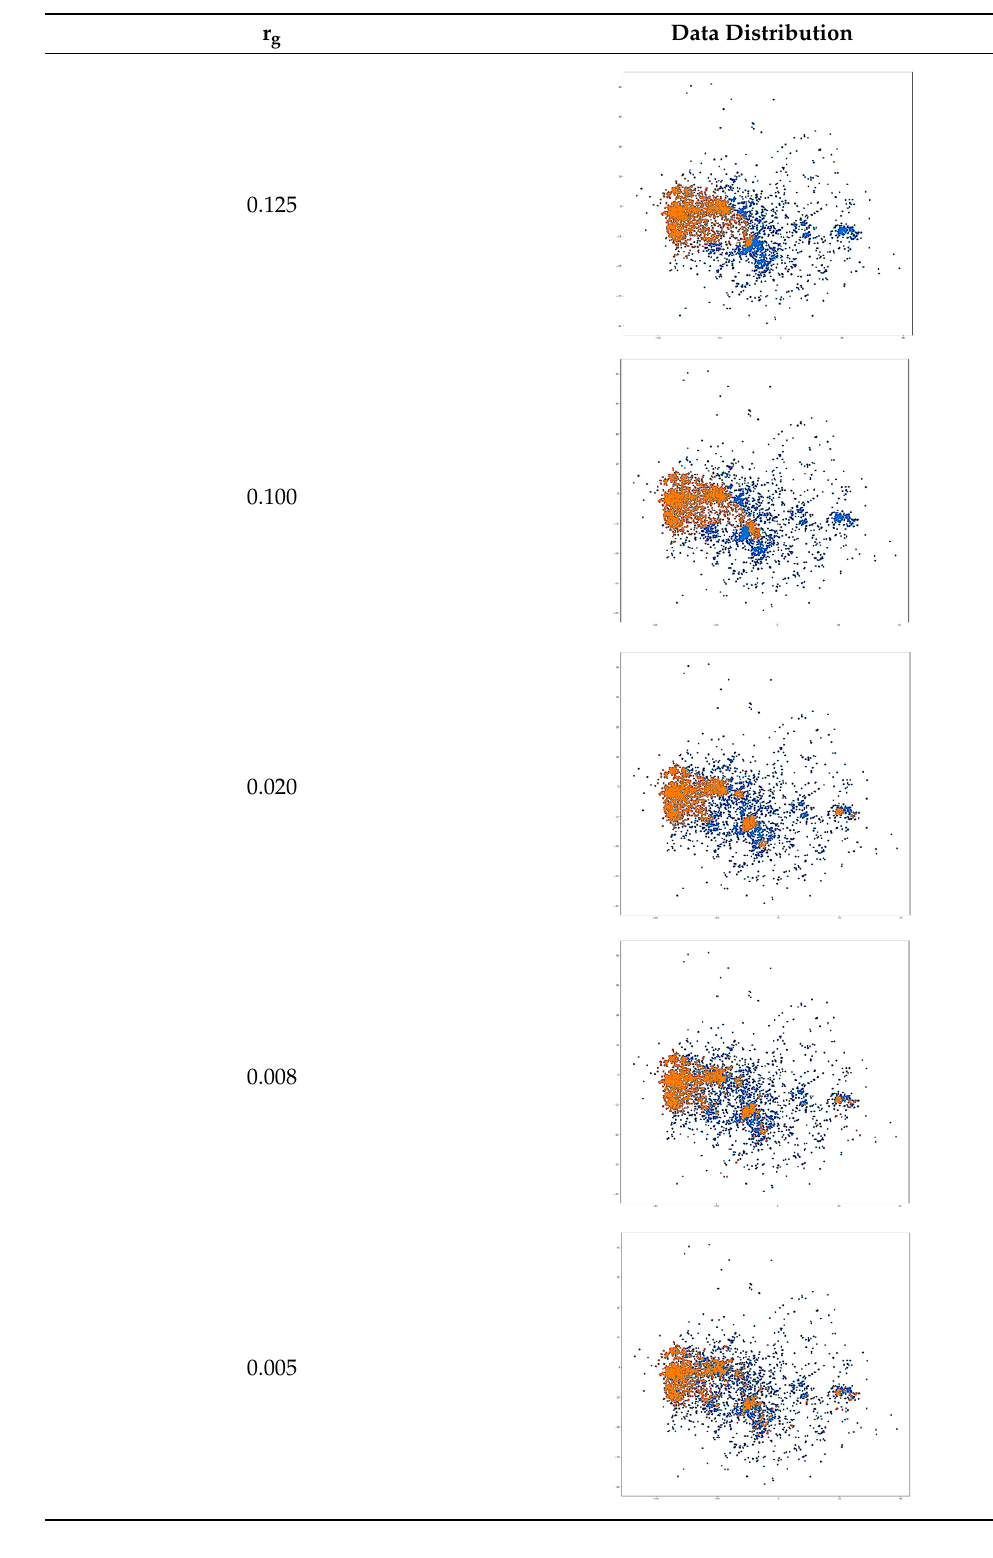
Table 4. Data distribution selected by high-DC (3000 Data of Class Number 0).